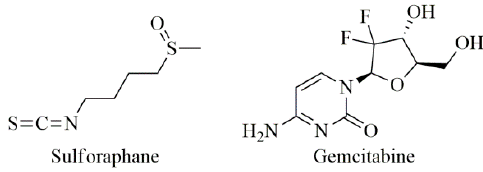
Figure 4. Chemical structures of sulforaphane and gemcitabine.